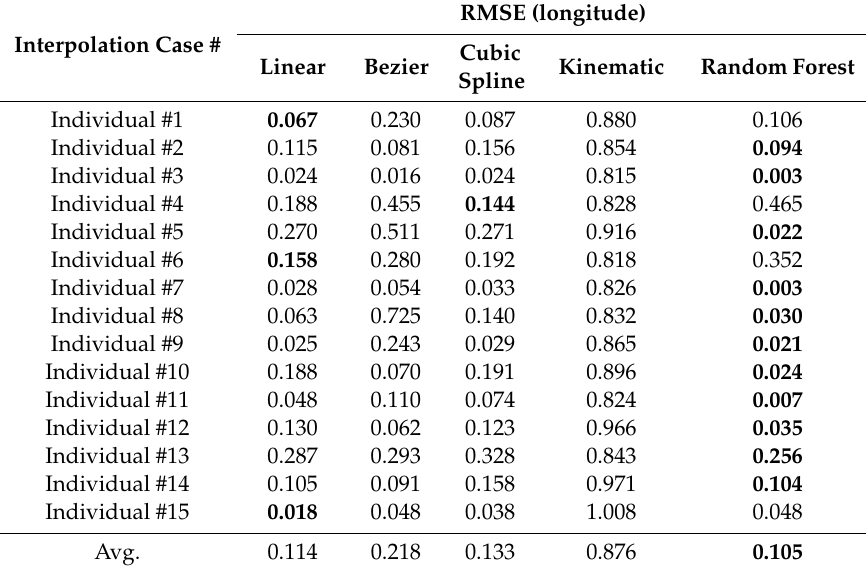
Table 5. Comparison of RMSEs for missing longitude records interpolation.